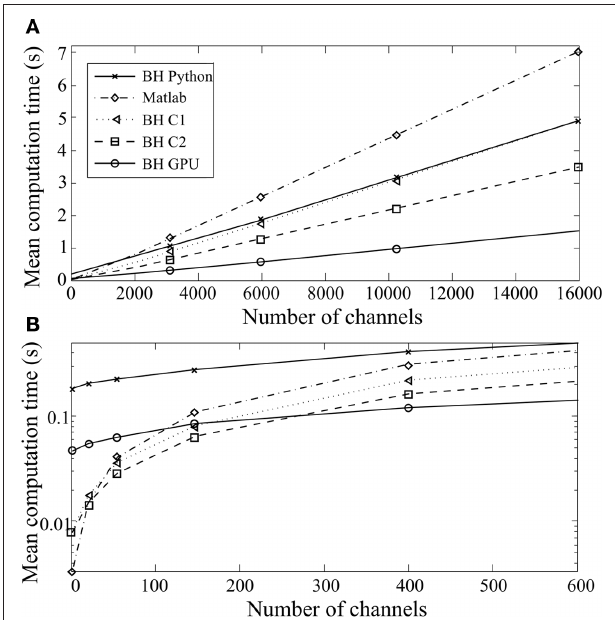
FiGUre 7 | Computation time taken to simulate a gammatone filterbank as a function of the number of channels, with a 200-ms sound at 20 kHz [(B) is a magnified version of (A)]. Five different implementations are compared: Brian Hears in pure Python with vectorization over channels (BH Python), Brian Hears with C code generation, sequential channels (BH C1) or vectorized channels (BH C2), Brian Hears with GPU code generation, and Matlab with operations on time-indexed arrays.